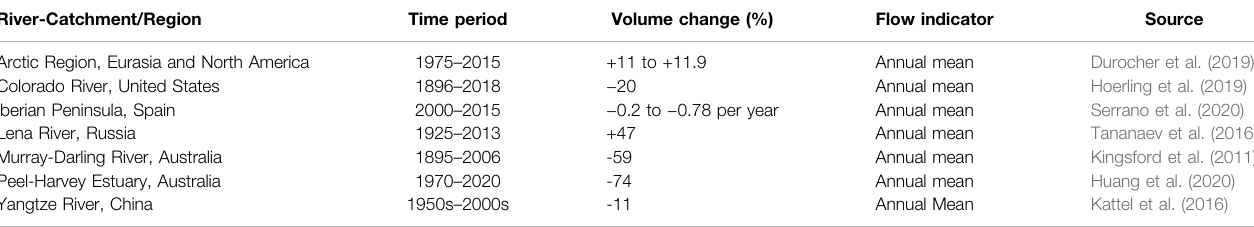
TABLE 1 | Changes in fl ow volumes reaching the sea from river-catchments and regions over the past century as a result of climate change and direct anthropogenic catchment modi fi cations. Multiple volume change values denote a range. River-Catchment/Region